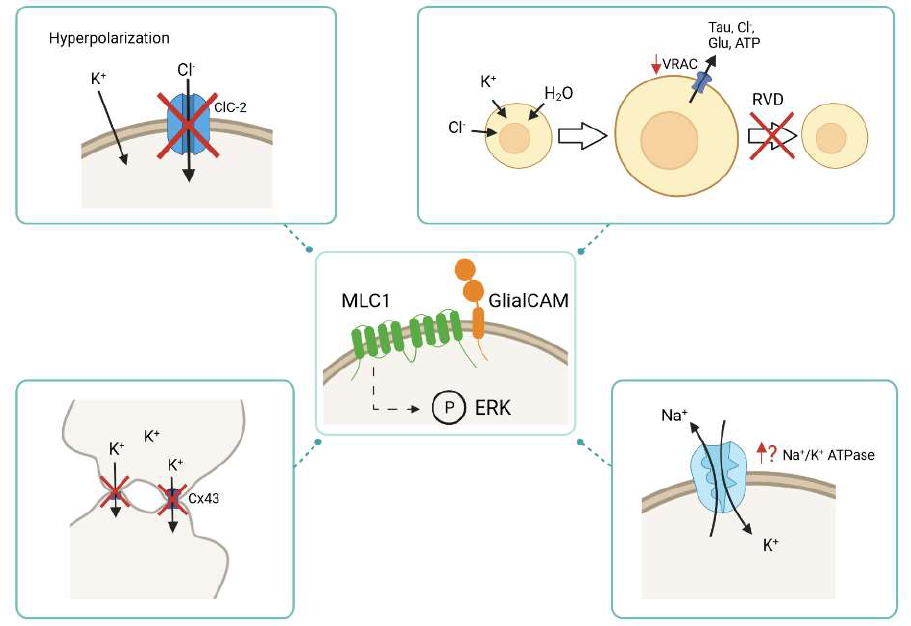
Figure 2. Physiological alterations caused by the lack of MLC1 and/or GlialCAM . MLC1/GlialCAM might regulate the activity of different transporters and ion channels through phosphorylation of ERK signalling transduction cascade. In the absence of MLC proteins, the activity of different trans- porters and ion channels is altered, such as the activity of ClC-2, VRAC, Cx43 and Na + /K + ATPase. During the hyperpolarization phase of a neuronal action potential, the activity of the chloride chan- nel ClC-2 is decreased in the absence of MLC1/GlialCAM. The lack of MLC proteins diminishes VRAC activity, which leads to an impaired regulatory volume decrease (RVD) response: an im- portant mechanism to shrink cells after cell swelling. The Cx43 localization in the absence of MLC1/GlialCAM is affected as it is internalized and it is no longer located at cell-cell junctions. It is thought that the activity of the Na + /K + ATPase is altered when MLC proteins are not present.